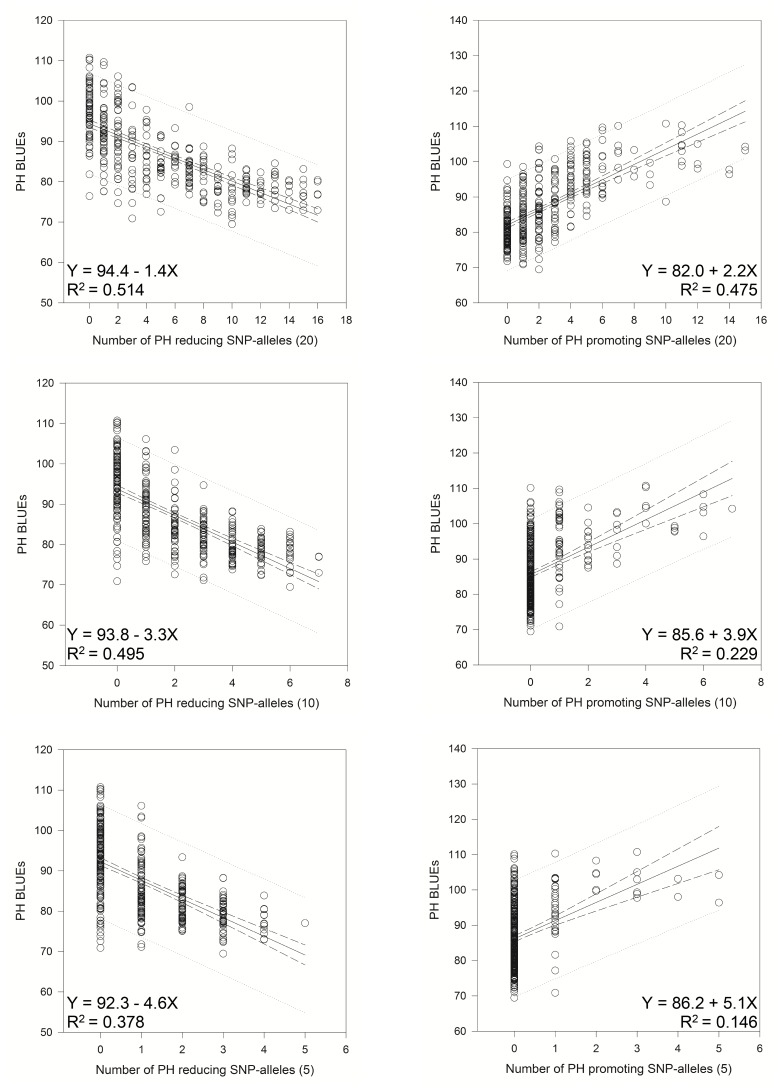
Linear regressions of the most PH reducing (“best”) and the most PH promoting (“worst”) SNP-alleles with PH-BLUEs.Linear regression resulted in a relationship between PH-BLUEs and the 20, 10 or 5 “best” or “worst” SNP-alleles from different loci in 372 varieties.